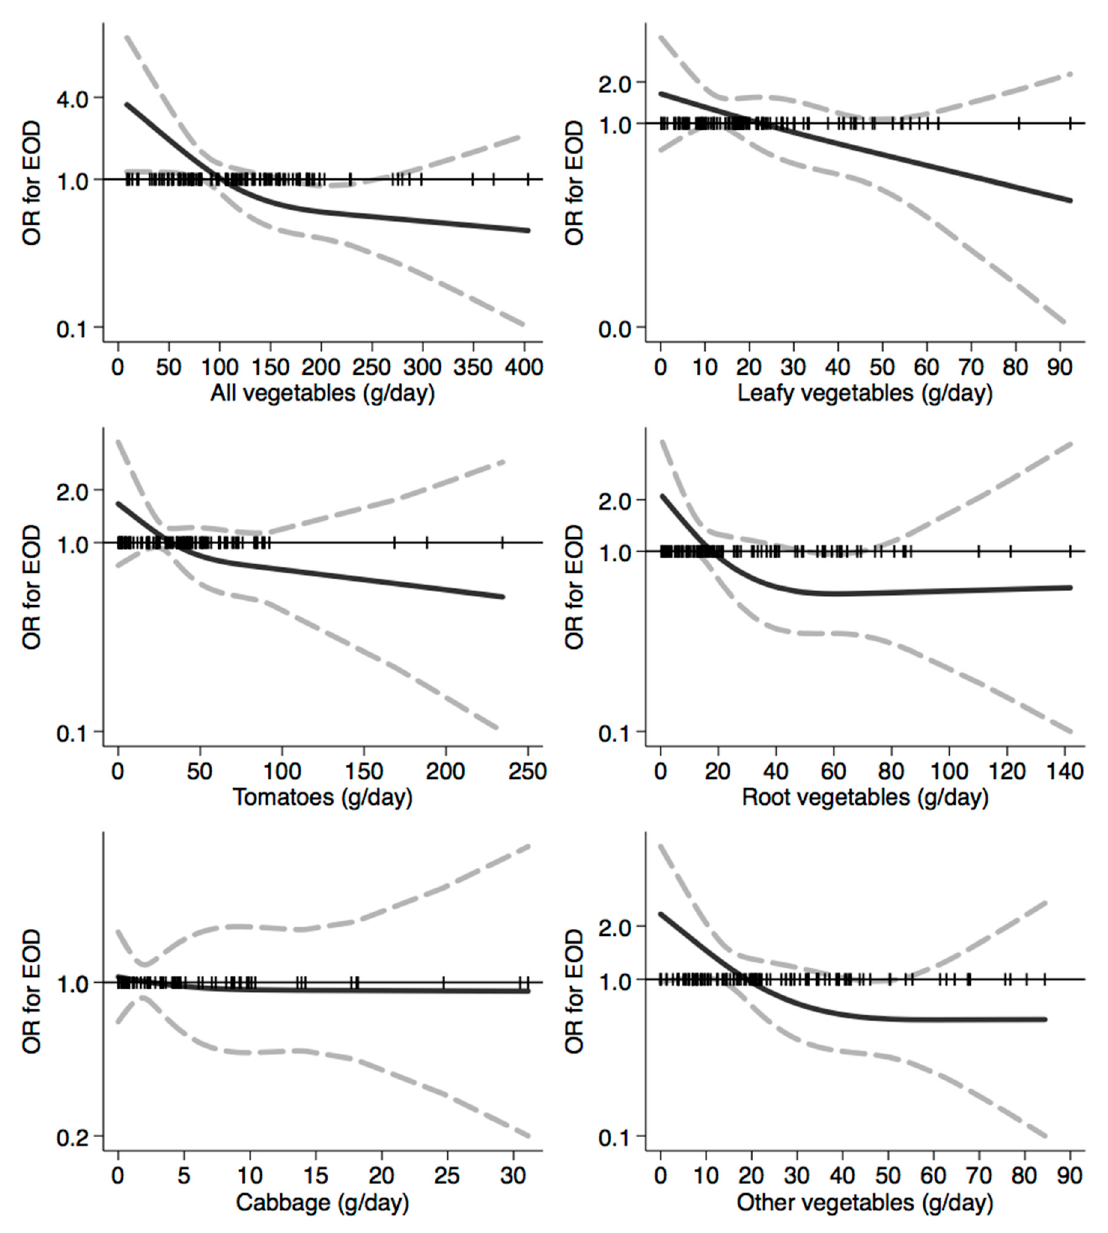
Figure 5. Spline regression analysis of early-onset dementia (EOD) risk for increasing intake of vegetables. The black line indicates odds ratios for dementia risk; dash gray lines are 95% confidence limits; the reference line at 1.0 with black spikes indicates the distribution of participant intake.